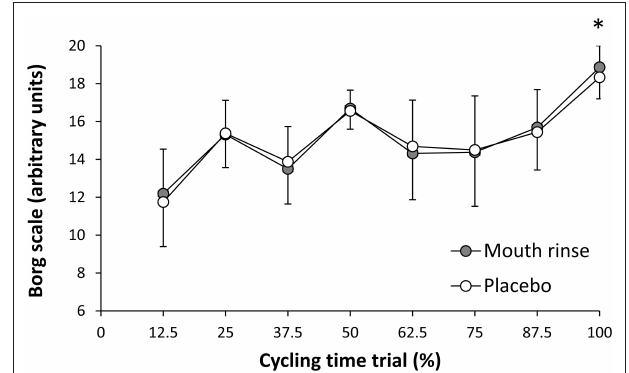
FIGURE 5 | Rating of perceived exertion, measured with the 6-20-point Borg scale, during the cycling time trial with carbohydrate mouth rinsing or with placebo mouth rinsing. *Different from placebo at P <